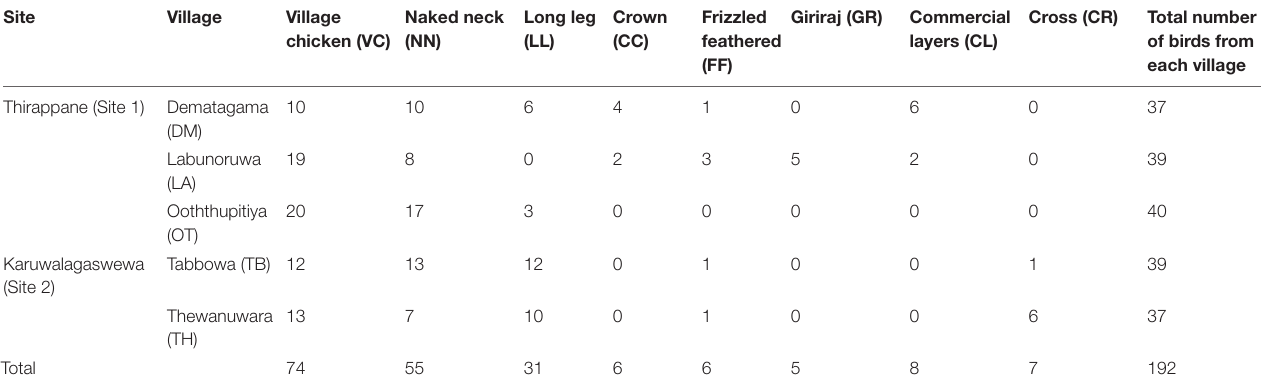
Naked neck Long leg Crown Frizzled Giriraj (GR) Commercial Cross (CR) Total number chicken (VC) (NN) (LL) (CC) feathered layers (CL) of birds from (FF) each